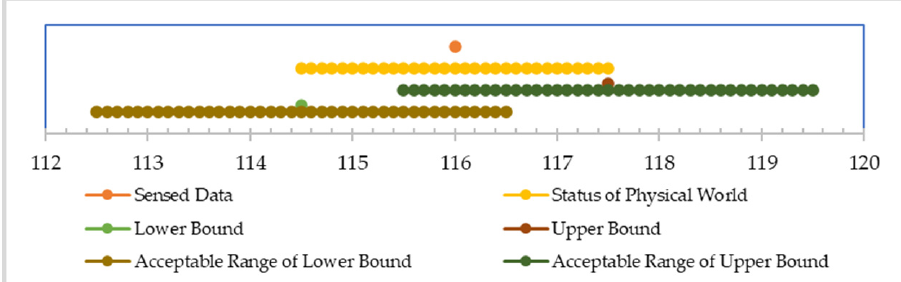
Figure 5. The bounded-error range of the raw data of voltage 116.